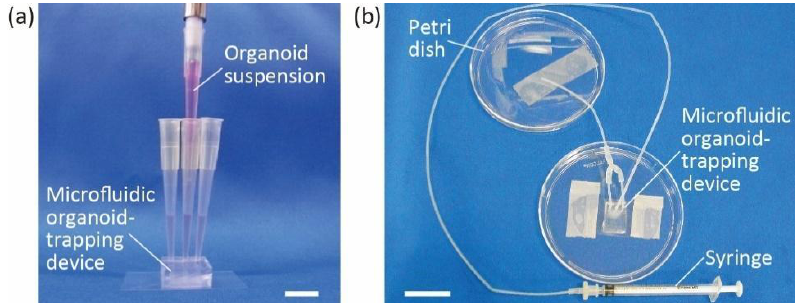
Figure 2. Experimental setup for organoid trapping and perfusion. ( a ) Introducing organoid sus- pension into the inlet of microfluidic organoid-trapping device. ( b ) Microfluidic organoid-trapping device connected to a syringe and tubes for organoid perfusion. Scale bars are ( a ) 1 cm and ( b ) 2 cm.